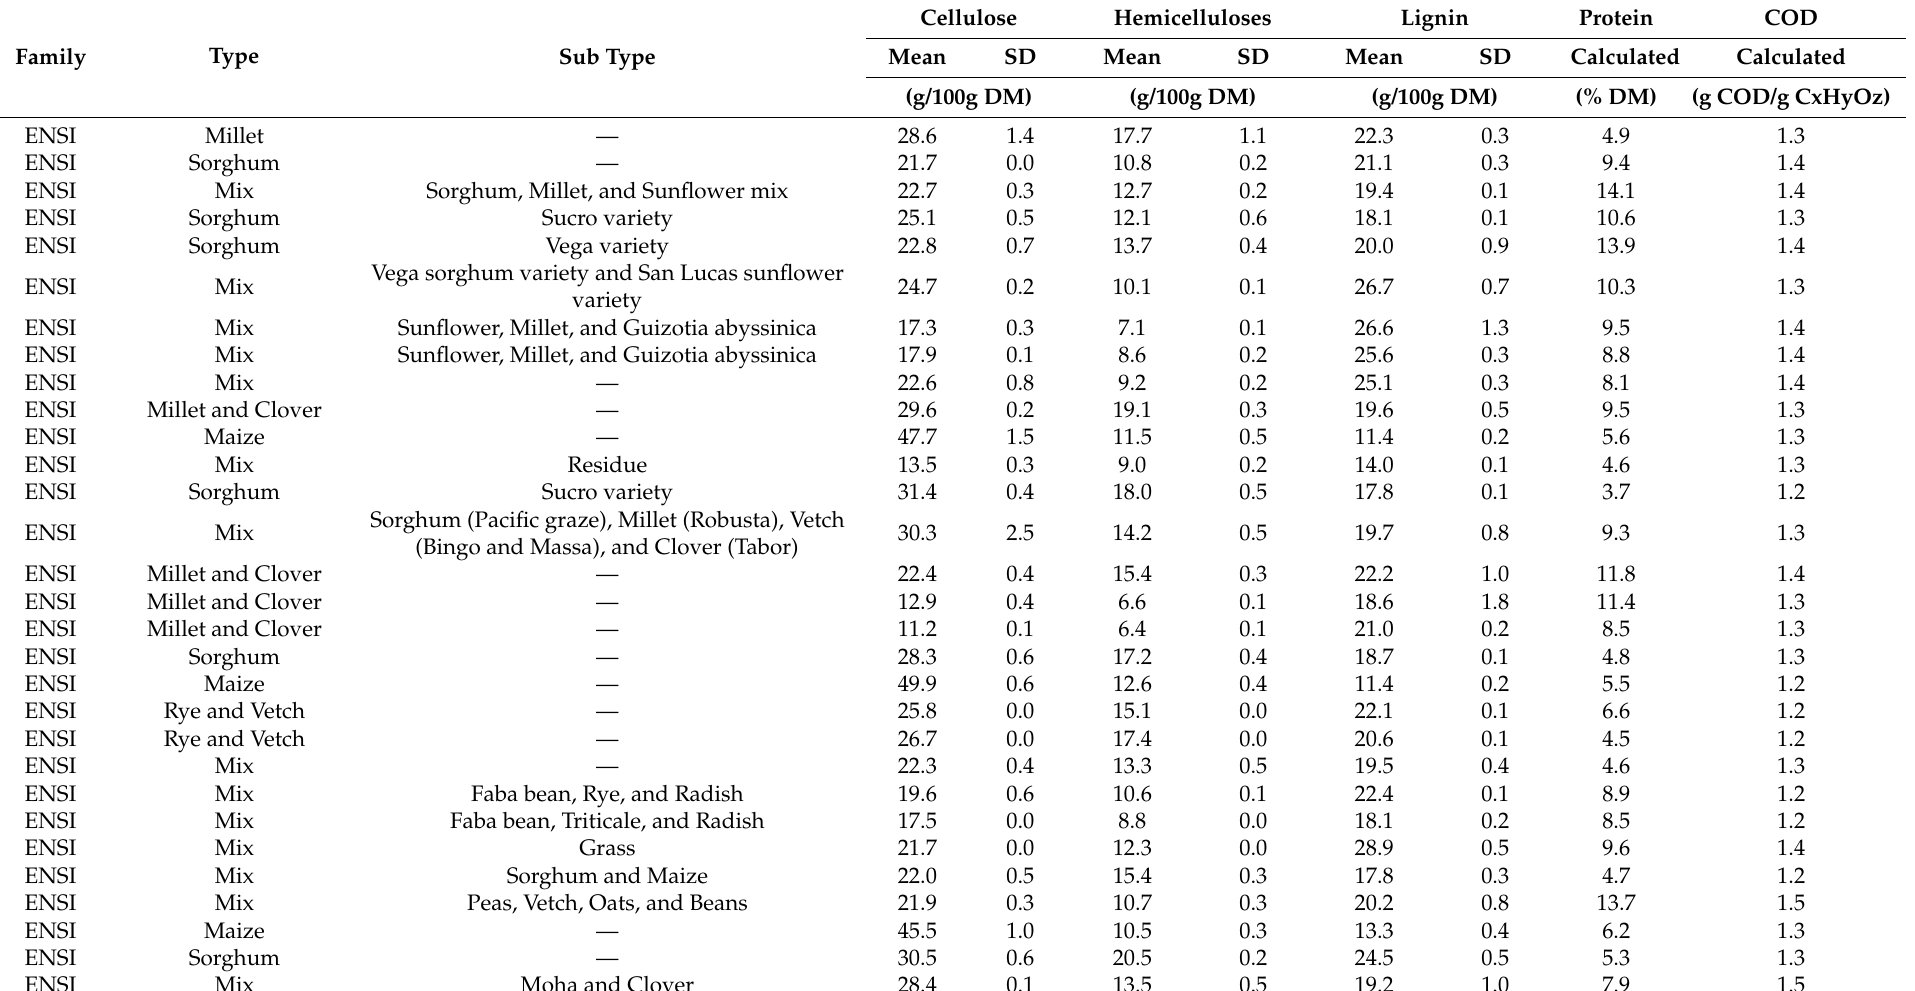
Table A2. Description of the substrates analyzed within the families: fibers, protein content, and COD, where SD is standard deviation, DM is dry matter, VS is volatile solids, and COD is the chemical oxygen